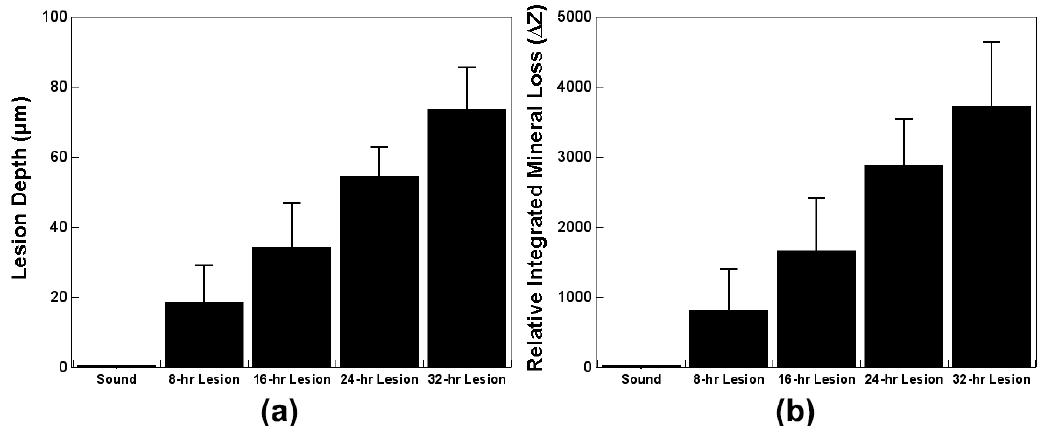
Figure 4. Mean ± S.D. for ( a ) lesion depth and ( b ) Δ Z from µCT measurements.